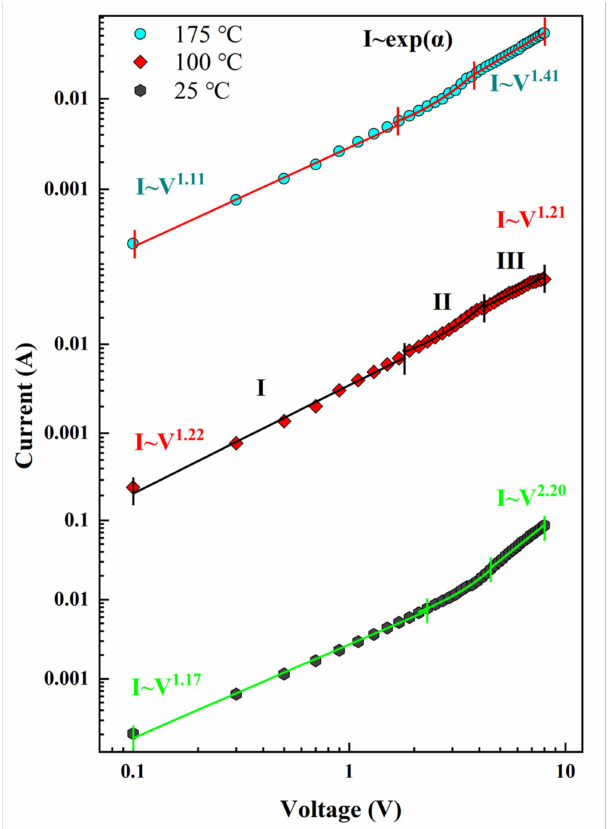
Figure 7. Log I –log V plots of the n-Ce:ZnO NL/p-BDD heterojunction at various temperatures. A plot of ln( I/V 2 ) versus 1/V is given in Figure 8 to investigate the interfacial carrier migration mechanism in heterojunctions. In general, the carrier migration mechanisms in heterojunction interfaces can be classified into three categories [47]. (I) When the external temperature is high, lots of carriers cross the interface through the energy generated